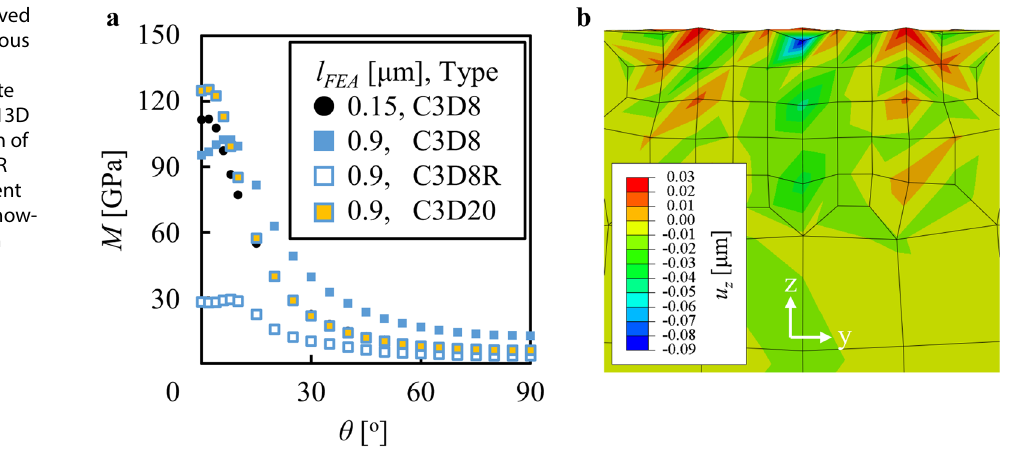
) at mesh sizes ( l ) of a , d 0.15 µm and b , e 0.45 µm at a tilt angle ( θ ) of 0° zz FEA